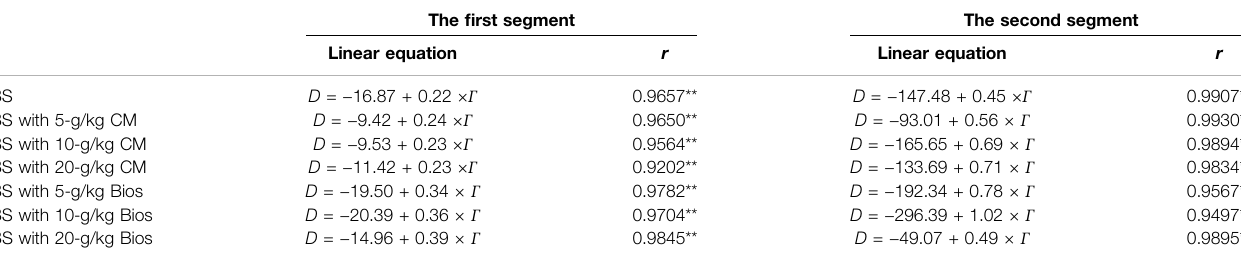
TABLE 3 | Parameters of the linear model for P desorbed from soils with and without organic matter incubation. The fi rst segment The second